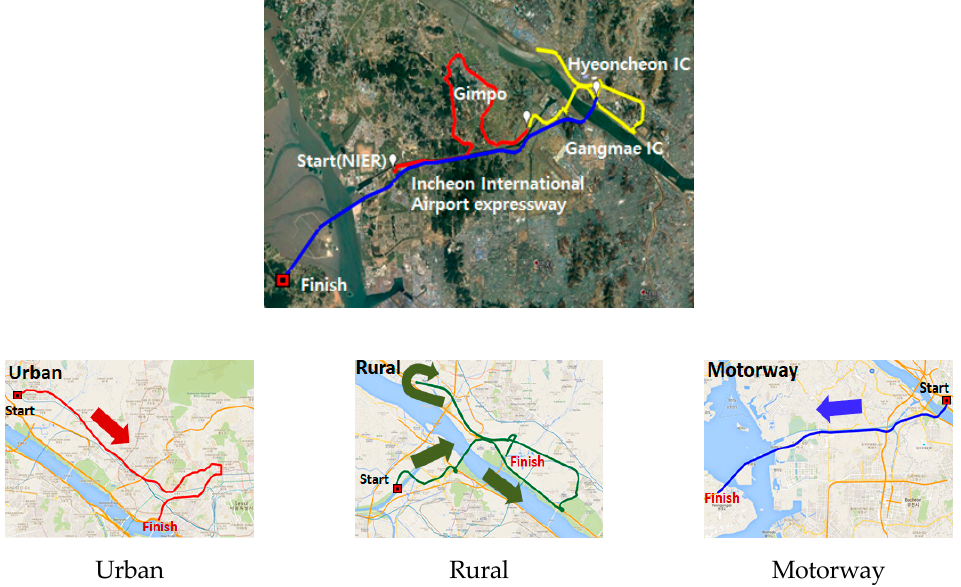
Figure 5. Driving routes for the Real Driving Emissions–Light-Duty Vehicles (RDE–LDV) cold-start